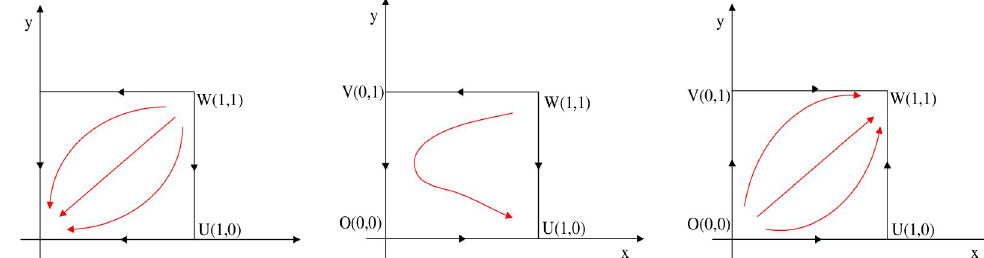
Fig 4. The evolution phase diagram of manufacturing enterprise path selection under the government subsidy for green technology innovation (I), (II) and (III).